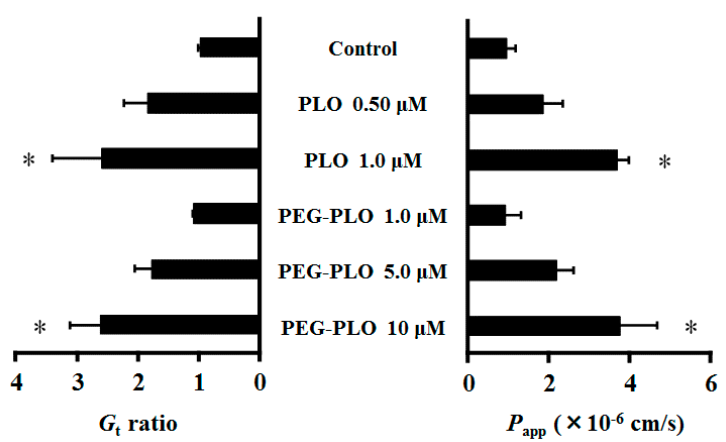
Figure 5. Effects of PLO and PEG-PLO on membrane conductance ( G t ) and permeability of fluorescein isothiocyanate dextran (FD-4) ( P app ) in Caco-2 cells. Relationship between G t and P app after application of PLO and PEG-PLO. Control group was treated with vehicle (HBSS). Each data column represents the mean ± S.E. ( n = 3–4). * p < 0.05 compared with the control group.